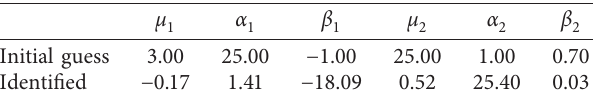
Table 1: Parameter identification for the hyperfoam material model.